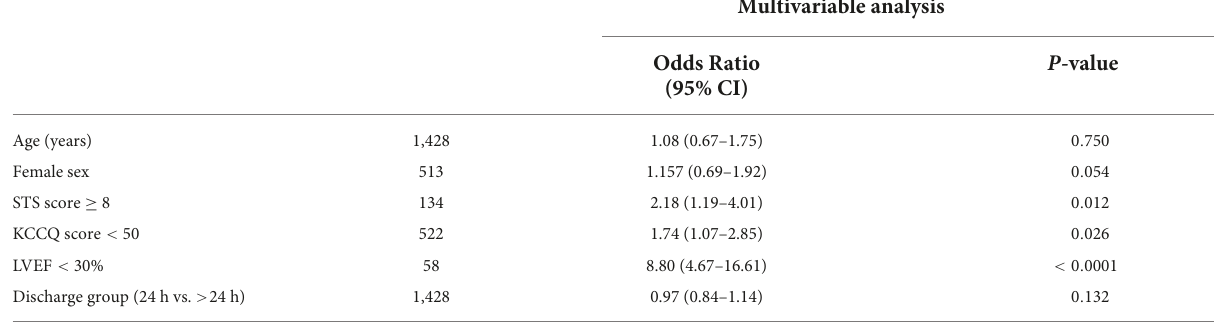
TABLE 7 Multivariable logistic regression of 30-day cumulative outcome after IPTW adjustment for patients discharge within 24 h and more than 24 h. Variable N 30-day Cumulative Outcome of 24 h vs. > 24 h